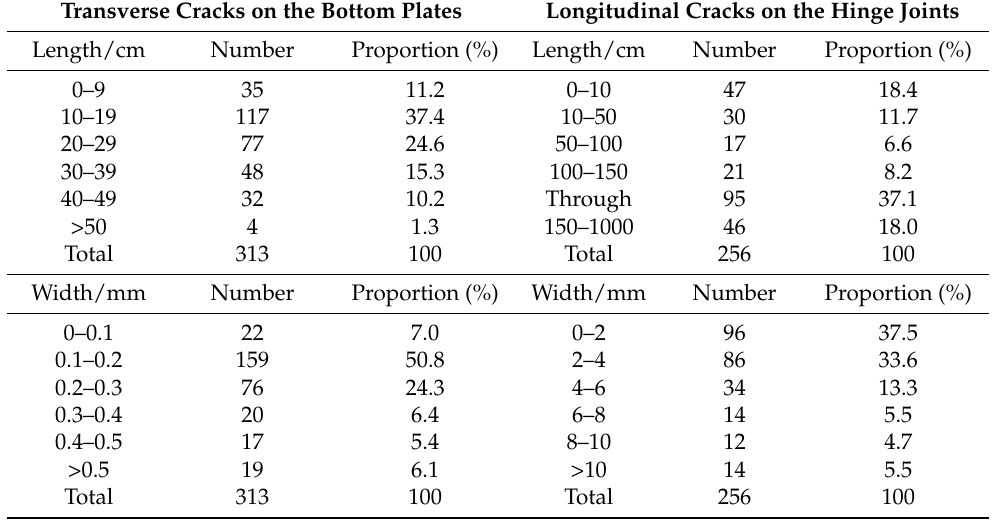
Table 7. Dimension of the